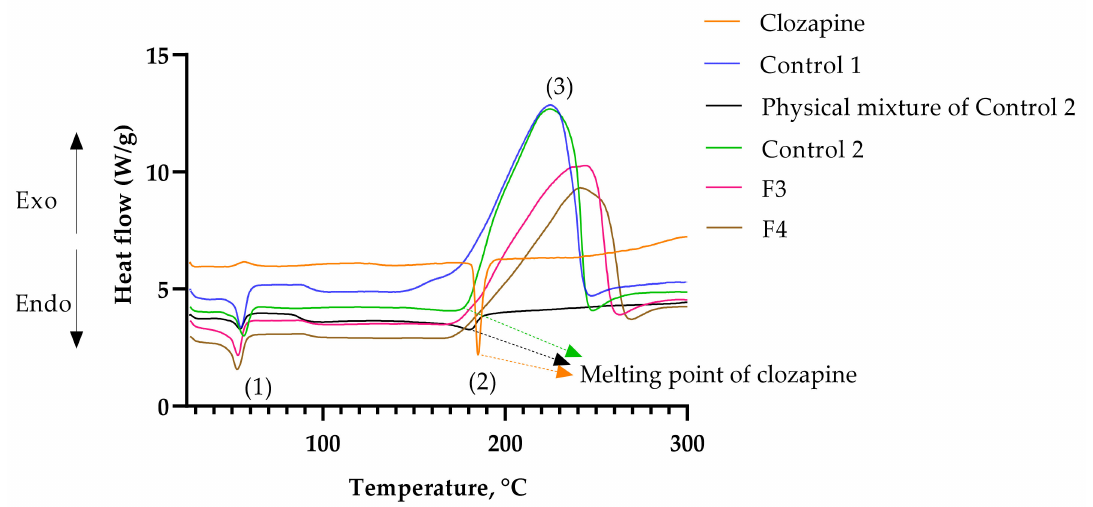
Figure 10. DSC thermogram. (1) indicates the melting peaks of P407, (2) melting peaks of clozapine, and (3) oxidative degradation peaks of the